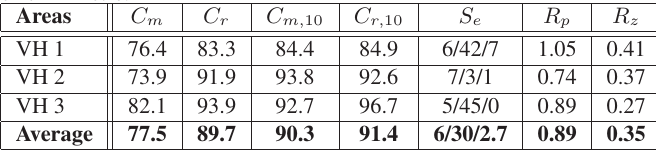
Table 2: Roof plane extraction results for the Vaihingen (VH) data set. Object-based: C m = completeness and C r = correct- ness ( C m, 10 and C r, 10 are for planes over 10m 2 ) in percent- age; S e = segmentation error ( 1 : M over-segmentation / N :